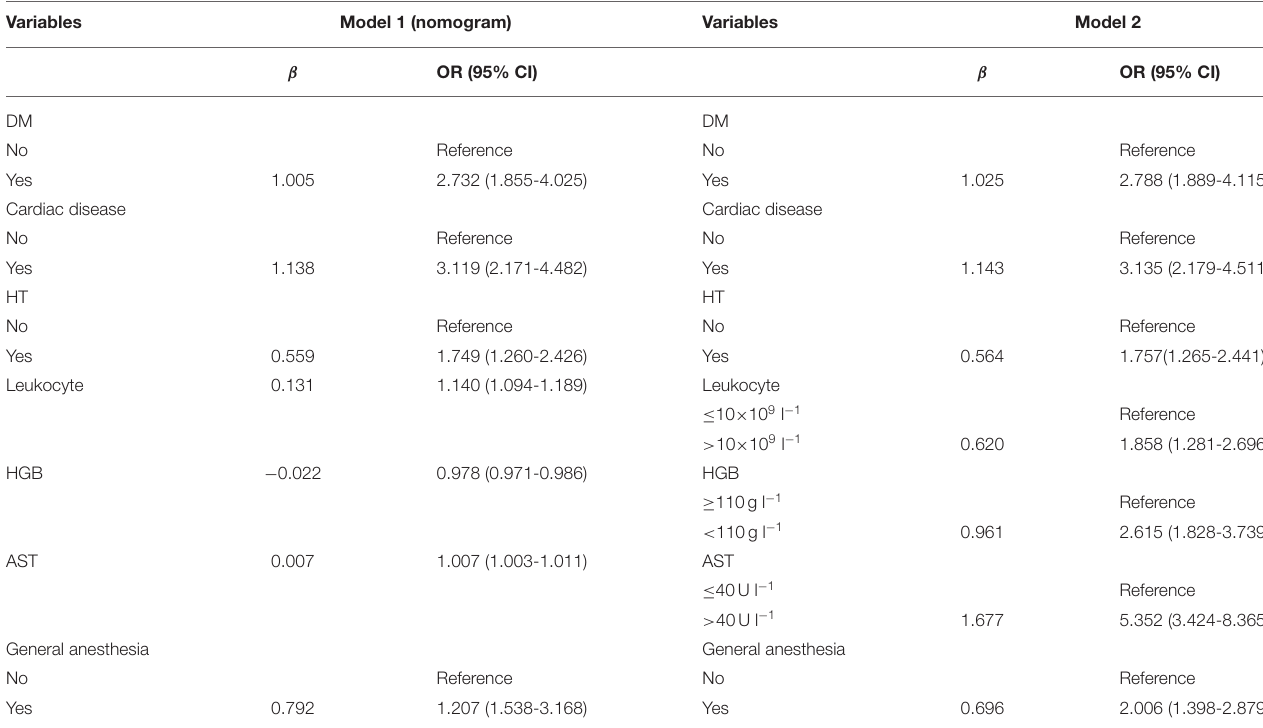
TABLE 4 | Results of multivariate logistic regression analysis in the training